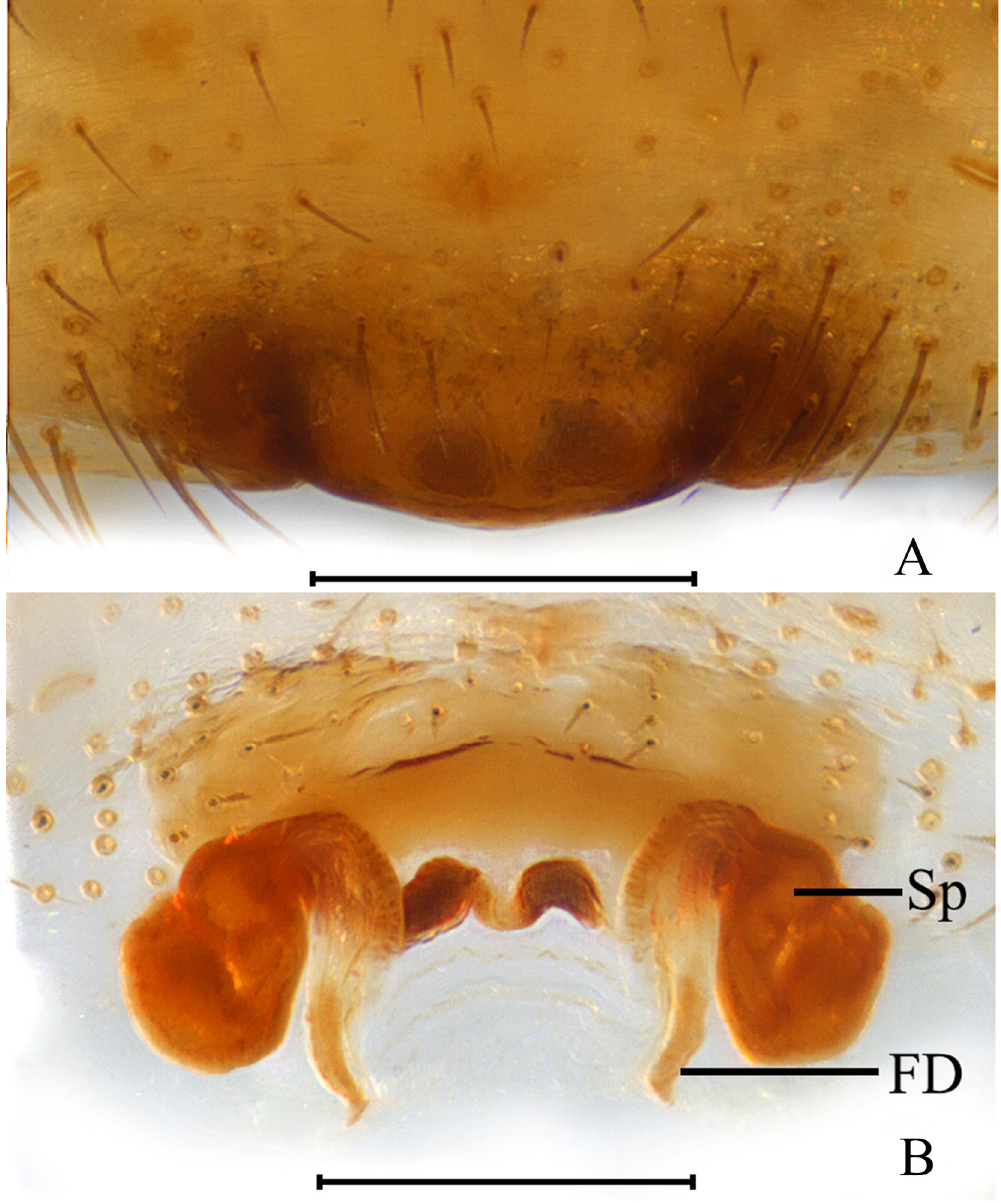
Fig. 8. Meta tangi sp. nov. Paratype ♀ (HNU-20071010). A . Epigyne, ventral view. B . Vulva, front view. Scale bars: 0,2